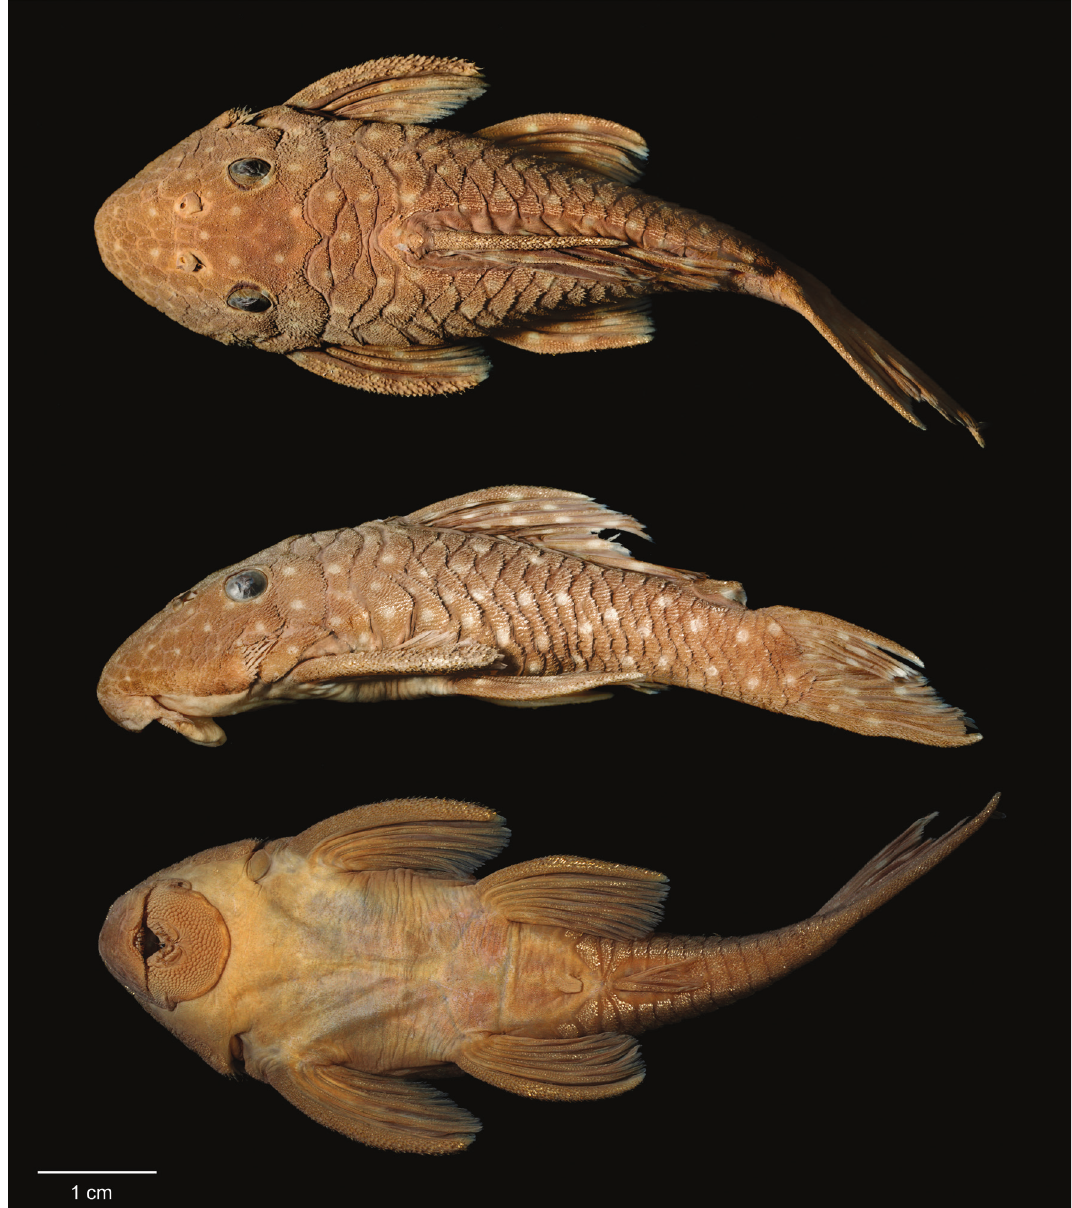
Fig. 13. Spectracanthicus tocantinensis , holotype, MZUSP 110989, 56.4 mm SL, rio Tocantins, Pará State, Brazil. Image by E.